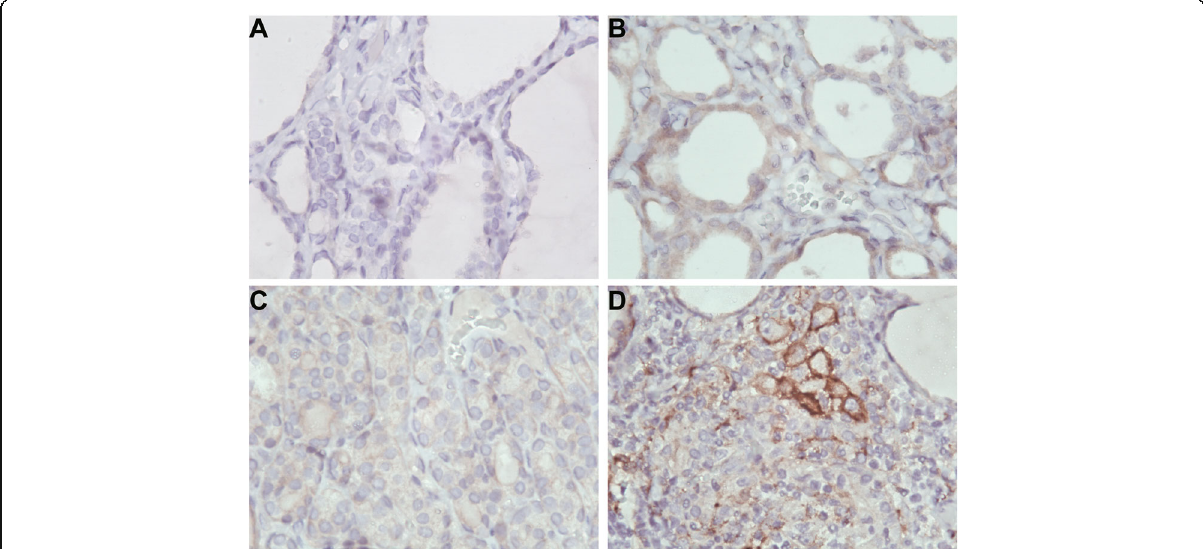
Fig. 5 The expression of PD-L1 in NG&noHT, NG&HT, PTC&noHT and PTC&HT tissues. A. NG&noHT (400×). B. NG&HT (400×). C. PTC&noHT (400×). D. PTC&HT (400×)